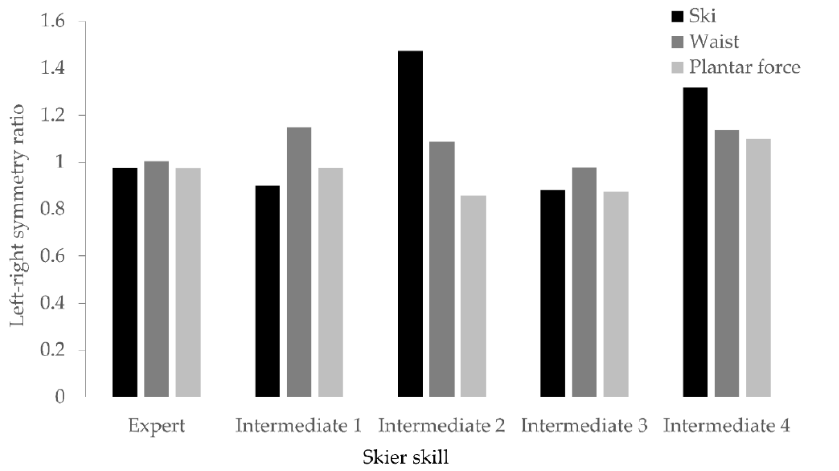
Figure 9. Left–right feature symmetry. The black, dark gray, and light gray bars represent the symmetry ratios of ski motion, waist rotation, and heel load ratio features, respectively. As the value approaches 1, it indicates that the feature has left–right symmetry.